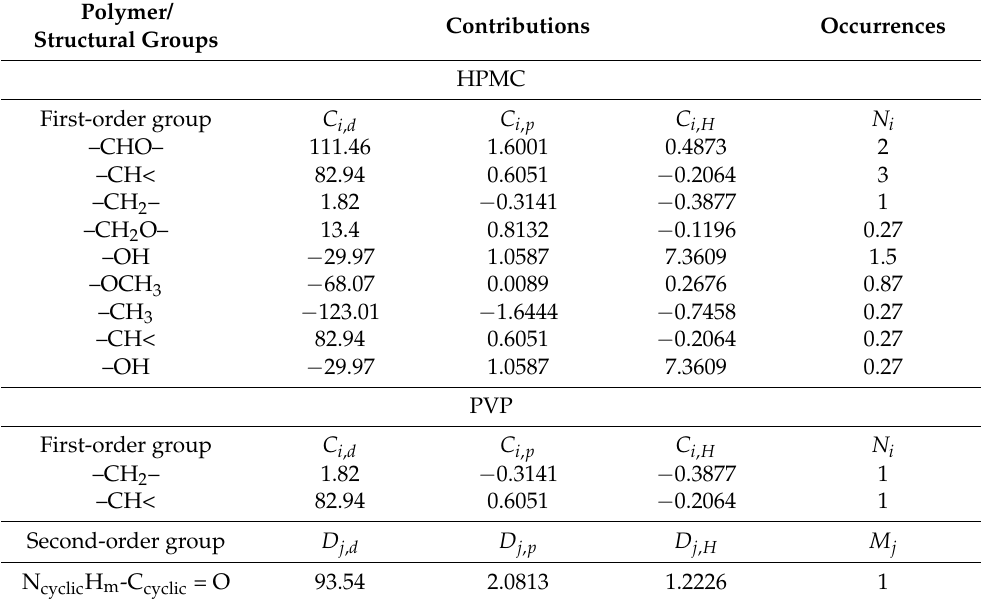
Table 4. Contributions of the first-order groups, C i , and second-order groups, D j , to the dispersion partial solubility parameter, δ d , the polar partial solubility parameter, δ p , and the hydrogen-bonding partial solubility parameter, δ H , that appears in HPMC and PVP [33,51].